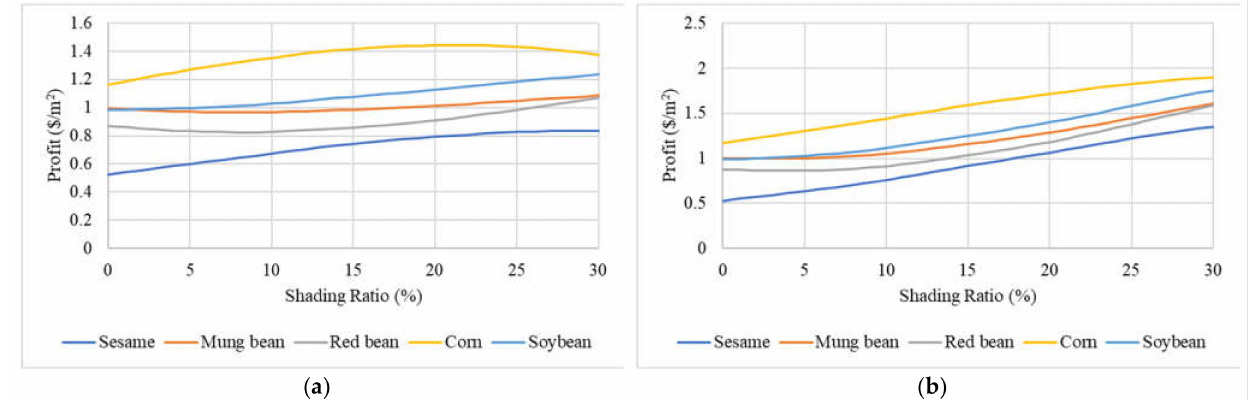
Figure 8. Estimation of the total profit of APV: ( a ) total profit with $0.005/kWh; ( b ) total profit with $0.01/kWh. APV: